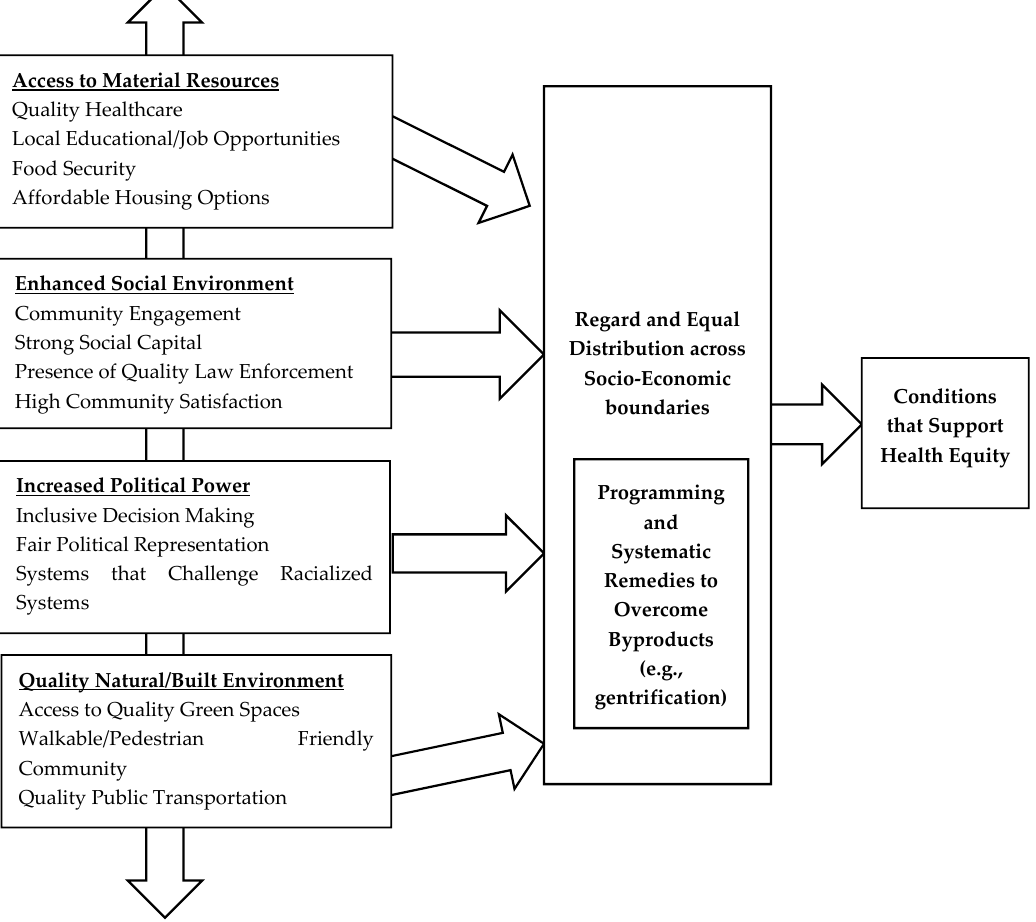
Figure 1. Conceptual Framework that Connects Urban Green Spaces with Factors that Support Health Equity (Adapted from [12–14]).